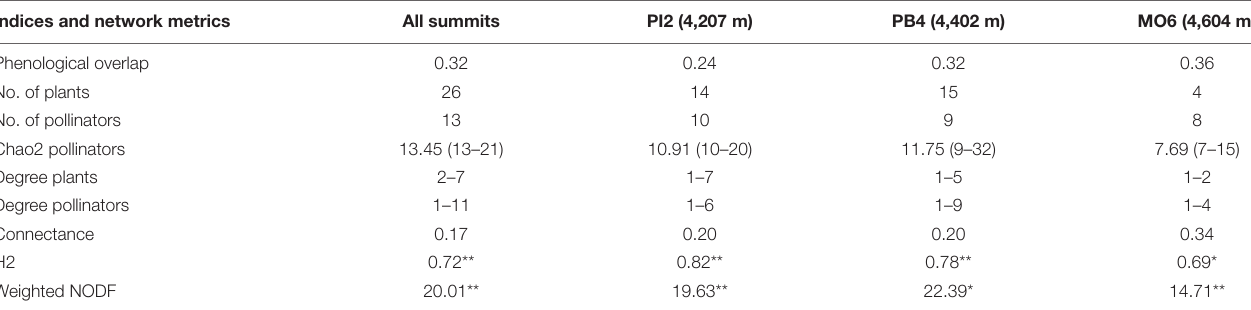
TABLE 2 | Phenological overlap index between plants and structural properties of pollination networks in superpáramo summits (la Culata-Piedras Blancas site, GLORIA–Andes,